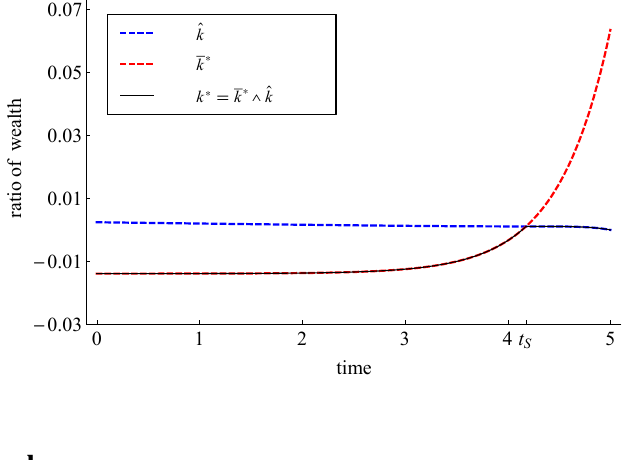
Figure 3. Optimal pre- and post-crash strategies for ρ = 0 . 5 and γ = − 13